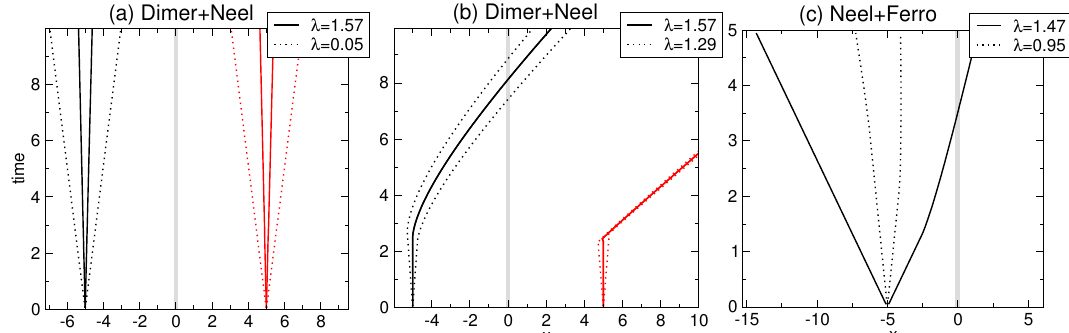
Figure 5: Trajectories of entangled quasiparticles ( α , λ ) and ( α , − λ ) after a bipartite quench in the XXZ chain. x and y -axis show space and time, respectively. Different lines correspond to different λ s. (a) Trajectories of the quasiparticles of the first species ( α = 1) after the sudden junction of the Néel state | N,0 〉 (24) (left) and the Dimer state (23) (right). (b) Trajectories of the quasiparticles of the second species ( α = 2) after the sudden junction of the Néel state | N,0 〉 (24) (left) and the Dimer state (23) (right). Note that the trajectories of pairs corresponding to solid lines are always very close (but not coinciding). This is due to the fact that λ ≈ π/ 2. (c) Trajectories of the quasiparticles of the first species ( α = 1) after the sudden junction of the Ferromagnetic state | F,0 〉 (25) (left) and the Néel state | N,0 〉 (24). The results are obtained by solving the equation of motion (31); We took ∆ = 10 in panels (a) and (b), and ∆ = 5 in panel